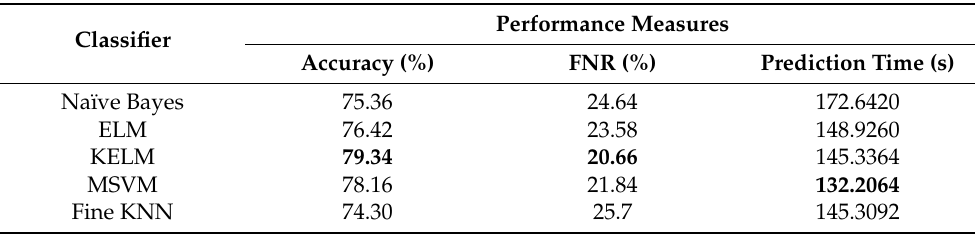
Table 7. Multiple skin lesion type classification results using only the DenseNet201 CNN model after transfer learning. Best values are shown in bold.